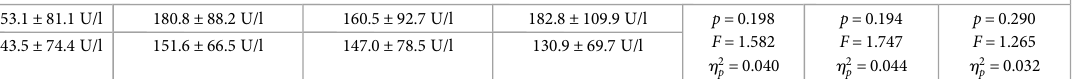
TABLE 6 Descriptive statistics and two-way ANOVA of creatine kinase. Group Creatine